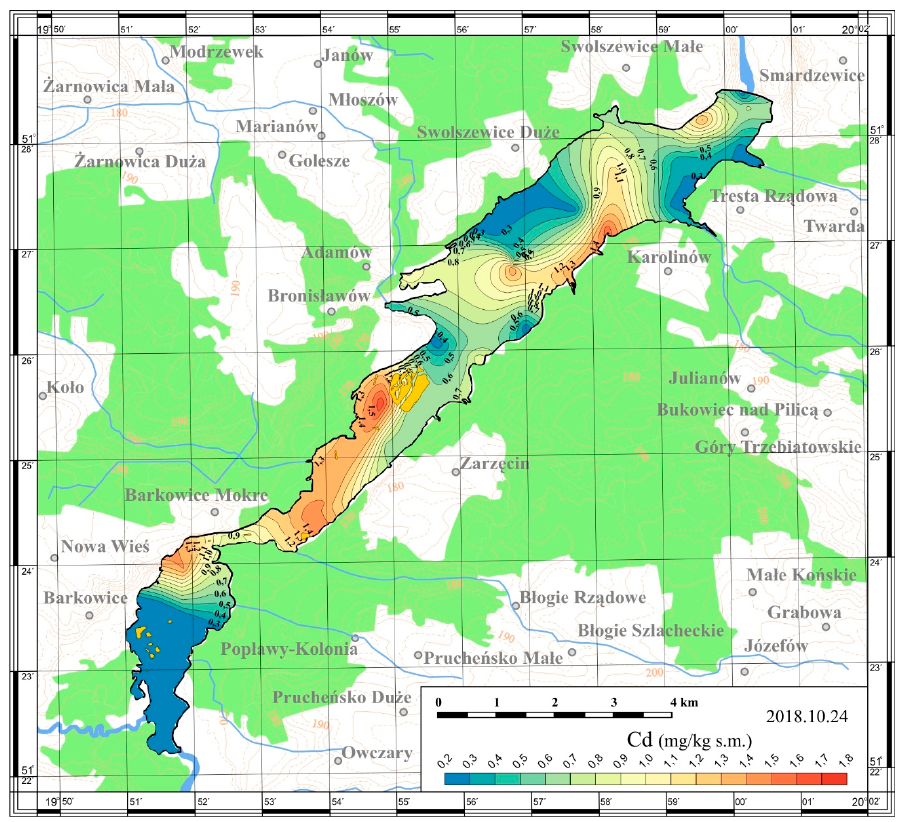
Figure 9. Spatial distribution of cadmium in bottom sediments of the Sulejów Reservoir.